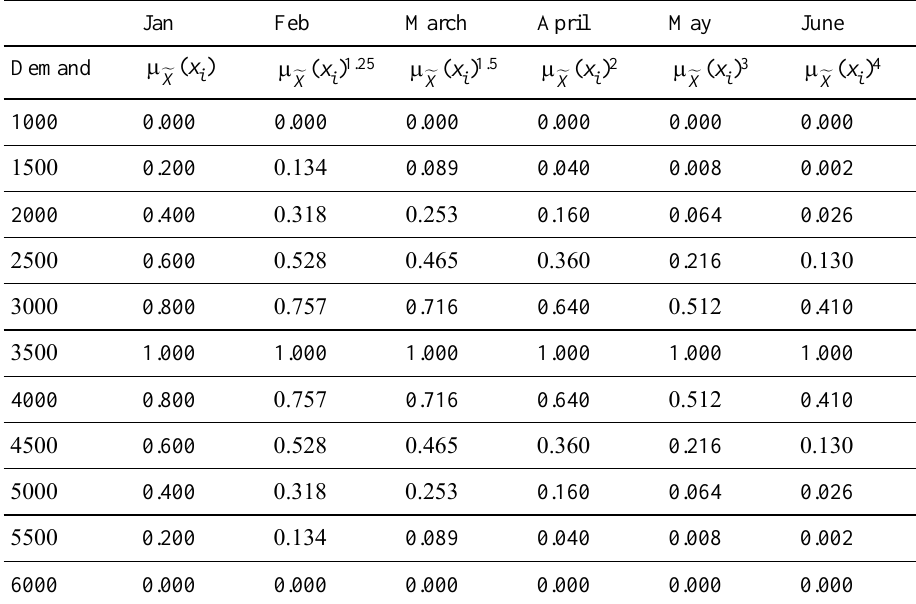
Table 2. Membership values of demand per